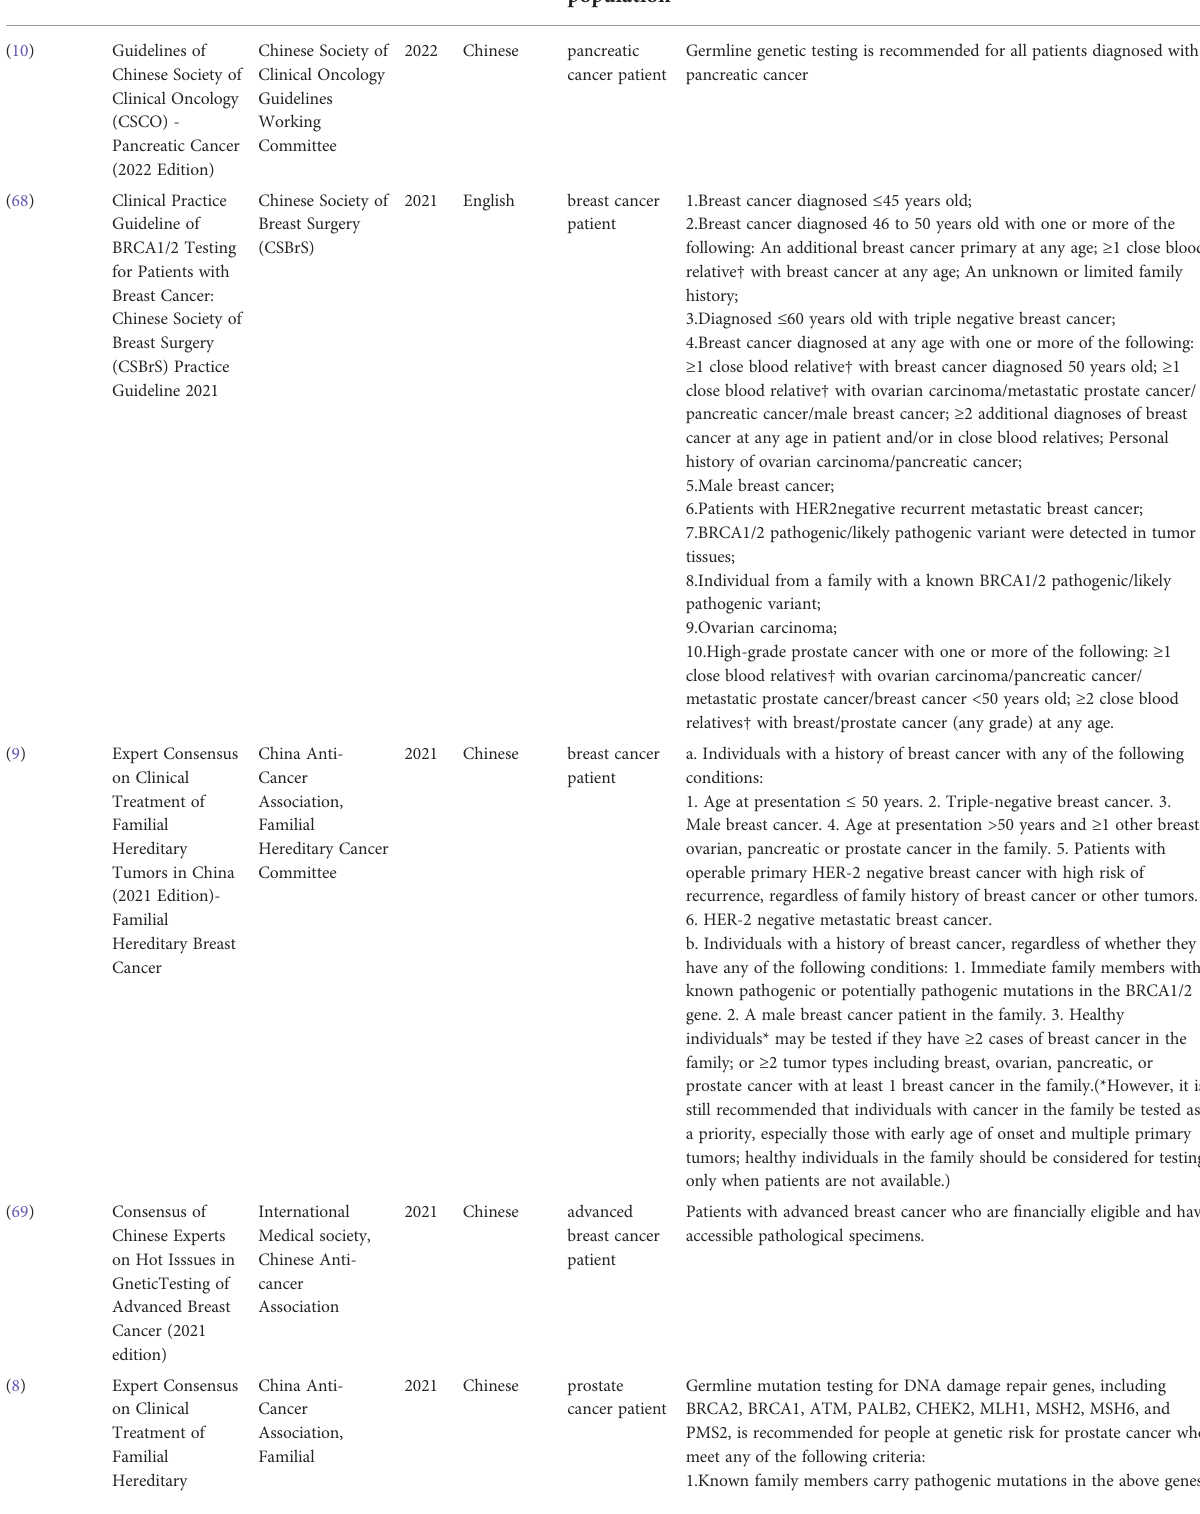
TABLE 2 Summary of guidelines and consensus about BRCA1/2 genetic testing in recent 5 years in China.